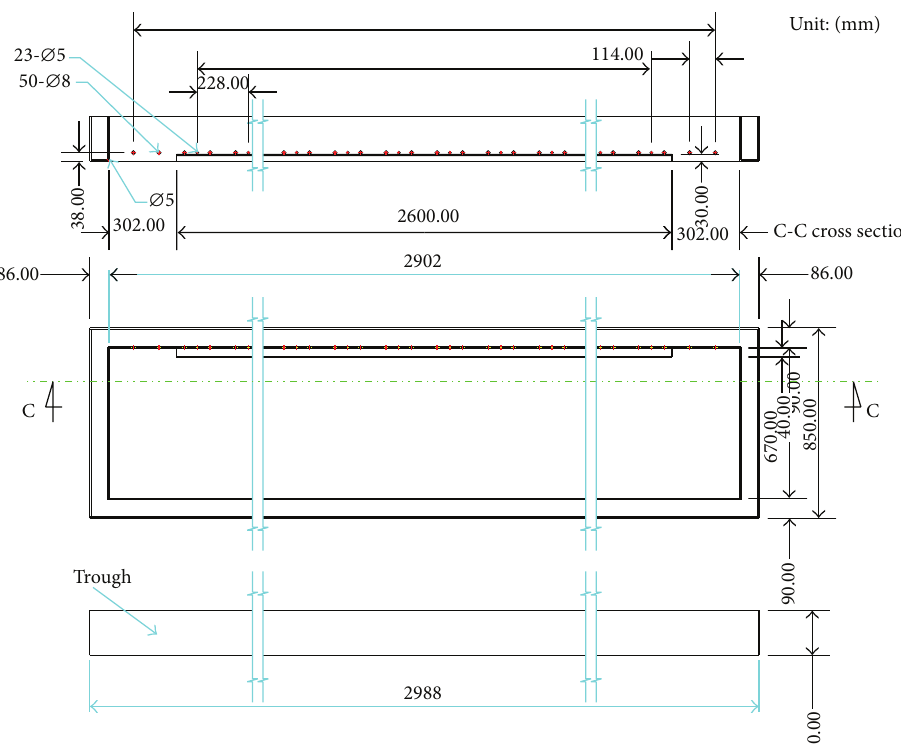
Figure 8: Trough in the space between the roller box surfaces and baffle